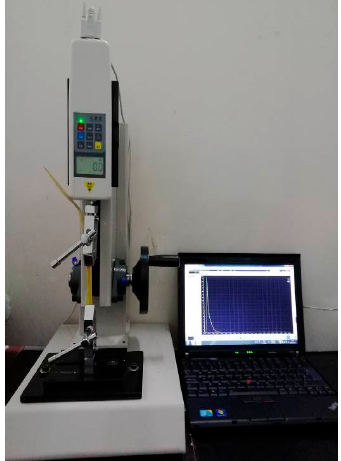
Figure 2. Status of rice plant and rice leaves and rice ear with grain.